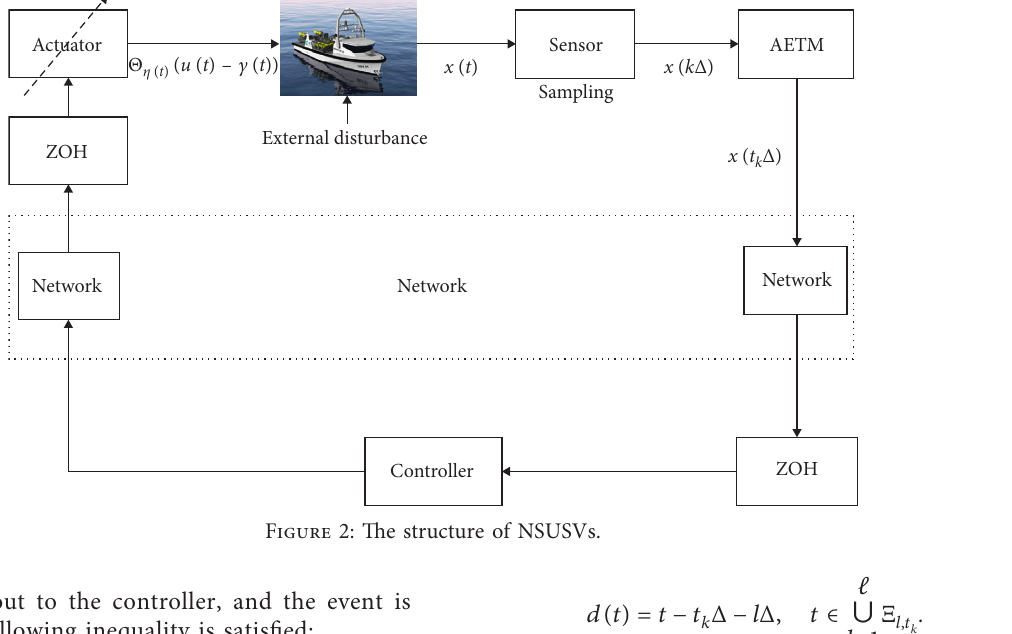
Figure 2: The structure of